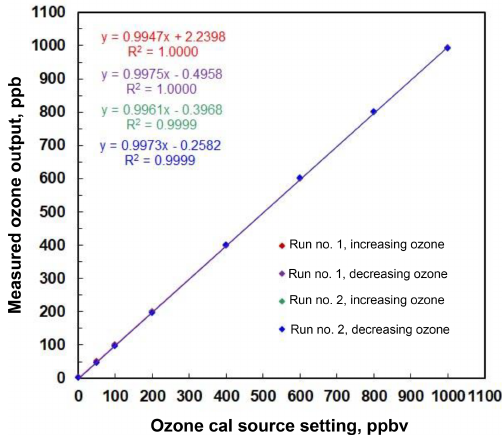
Figure 4. Linear regression for the measured outputs of a Model 306 Ozone Calibration Source in Fig. 3. Note the excellent agree- ment among the four data sets of increasing and decreasing ozone output concentration. Note that the four regression lines are indis- tinguishable.